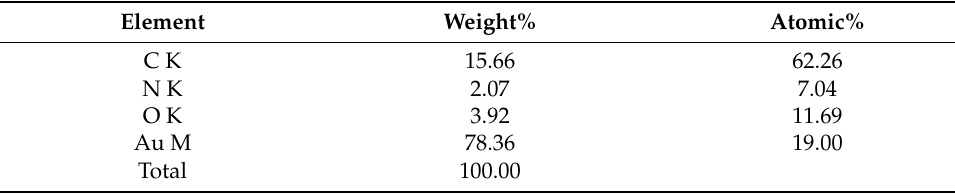
Table 2. Elemental composition of various elements in AuNPs sample.